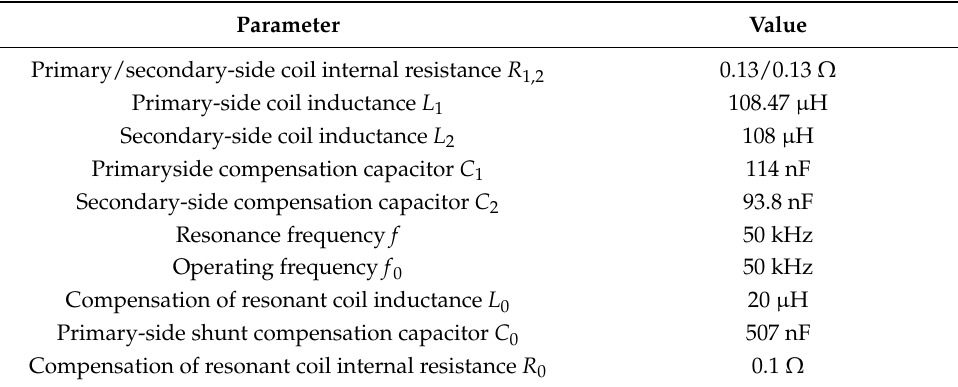
Figure 4. The schematic diagram of system parameter identification. Particle Swarm Optimization (PSO) is a search algorithm to find the optimal solution through collaboration and information sharing among individuals in a population which is used in this paper. Compared with the traditional algorithm, it has the advantages of being easy to implement with a few adjustment parameters, but due to its tendency to fall into local optimum, time-varying weight coefficients are introduced. This coefficient can